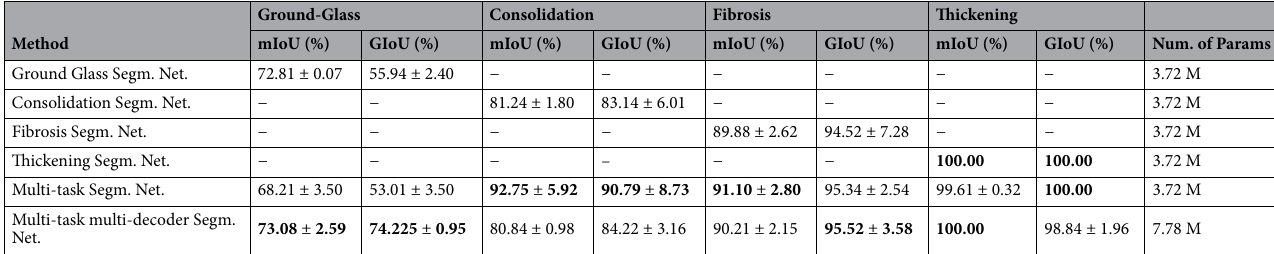
Table 2. Lesion Segmentation Performance on CC-CCII Dataset. Significance values are in bold.